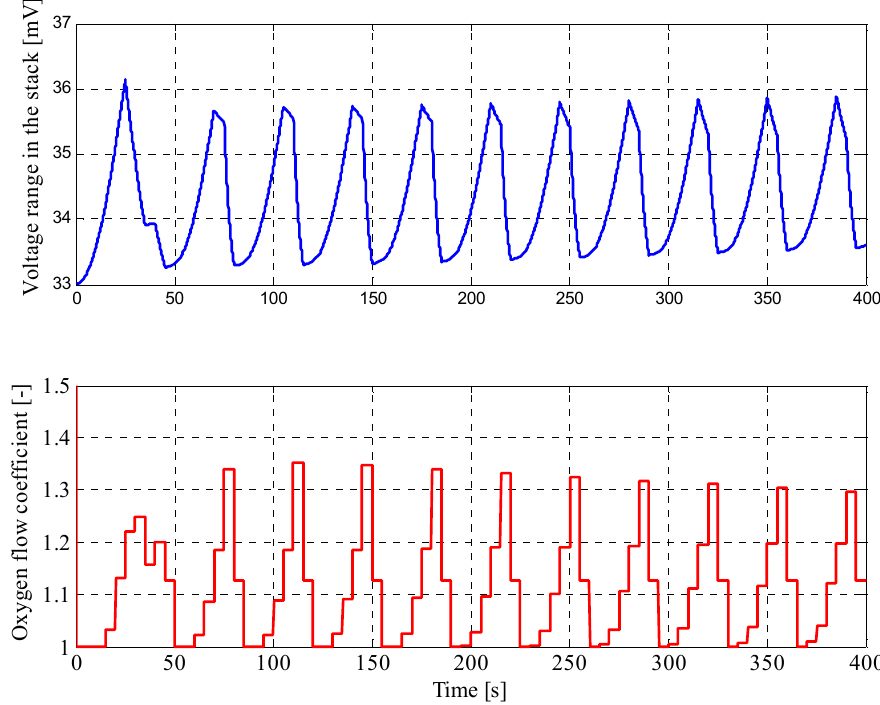
Figure 13. Voltage range and oxygen flow coefficient for the fuzzy control procedure with simulation parameters set to R U , z = 35 mV and ∆ t s = 5 s (initial R U = 33 ( mV ) , k O